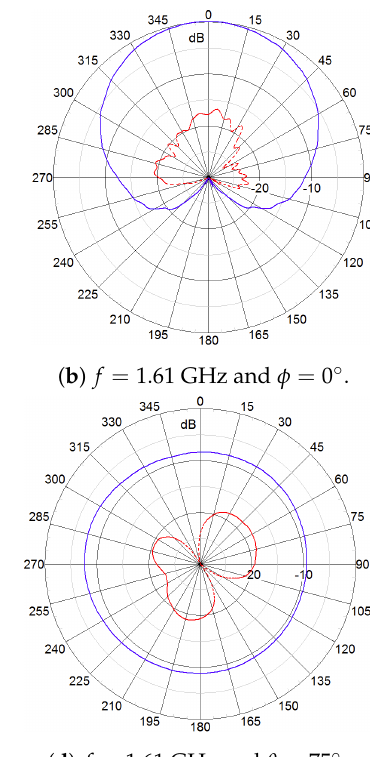
Figure 2. Measured radiation patterns (normalized) of the RHCP output of the 2pol antenna prototype. (Red) RHCP gain and (blue) LHCP gain.